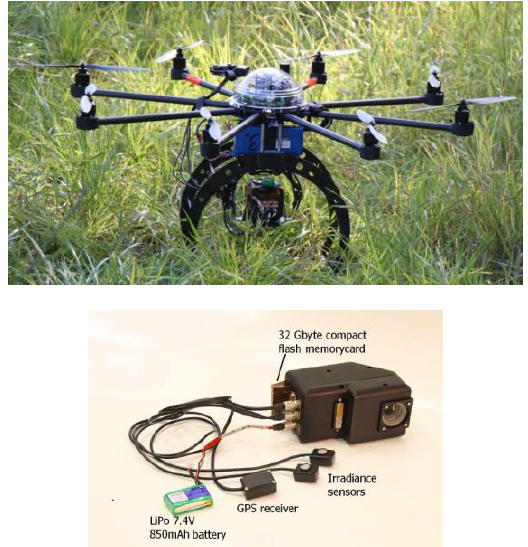
Figure 2. Top: MicroKopter UAV. Bottom: spectrometric FPI camera.